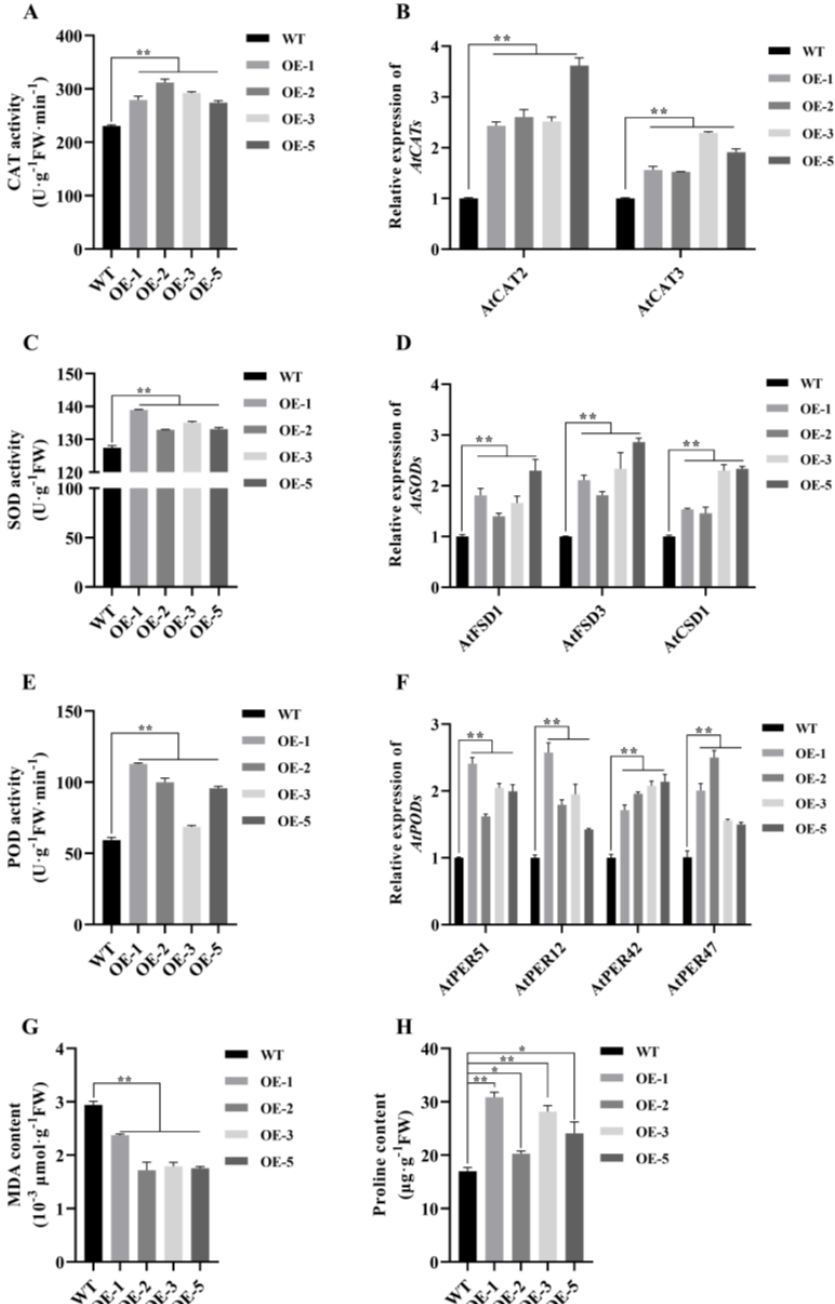
Figure 5. Antioxidant enzyme activity, compatible solute concentration, and expression level of the genes encoding Arabidopsis catalase (CAT), superoxide dismutase (SOD), and peroxidase (POD) in MsNF-YB21 overexpression lines were higher than in WT under normal conditions. ( A ) CAT activity analysis. ( B ) SOD activity analysis. ( C ) POD activity analysis. ( D ) Expression patterns of the CAT genes. ( E ) Expression patterns of the SOD genes. ( F ) Expression patterns of the POD genes. ( G ) Malondialdehyde (MDA) content analysis. ( H ) Proline content analysis. AtACT2 was chosen for the internal quantification control of Arabidopsis genes. Data are shown as means ± SE from three replicates of each 50 representative plants used. Significant differences were assessed using Student’s t -test in comparison to WT (single asterisks denote p < 0.05; double asterisks denote p < 0.01).